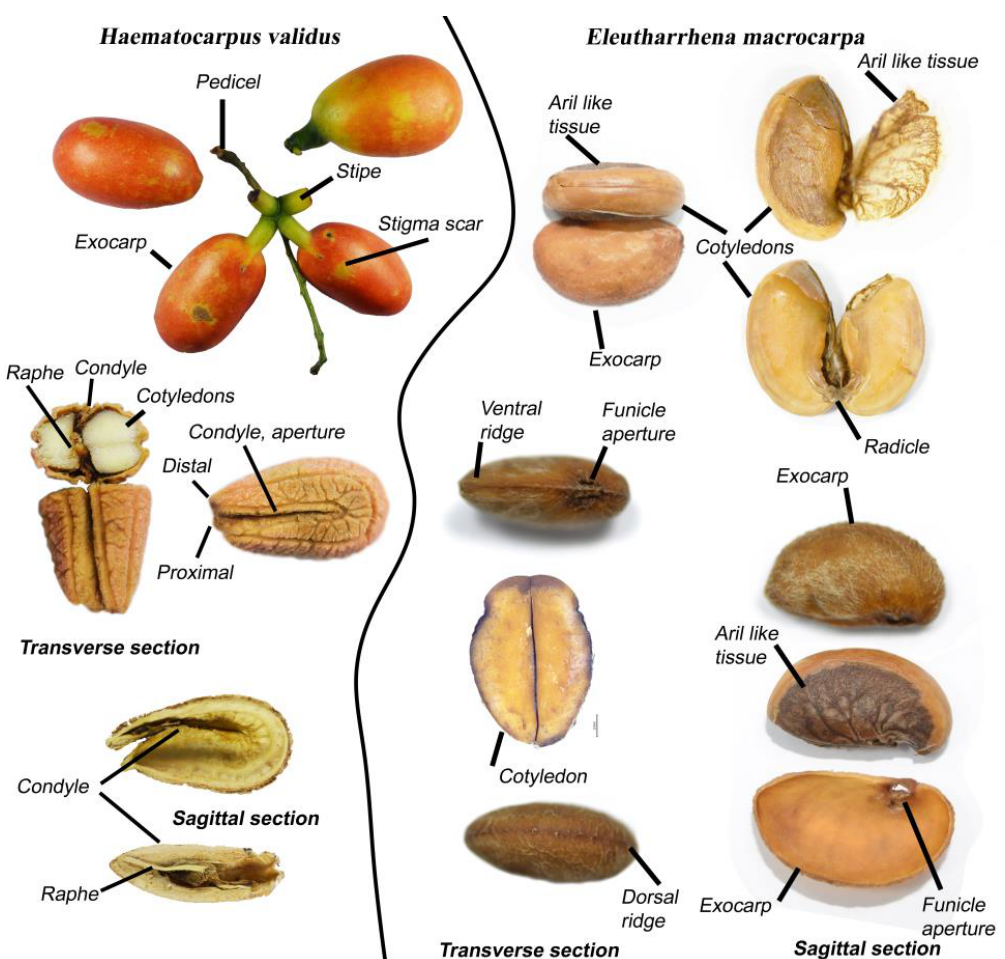
Figure 3. Fruits morphology of Haematocarpus validus and Eleutharrhena macrocarpa (sagittal and transverse sections).